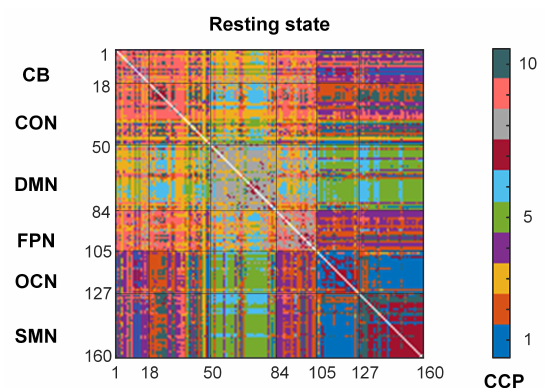
Figure A4. The CCPs in the original Euclidean space obtained with a K-means clustering